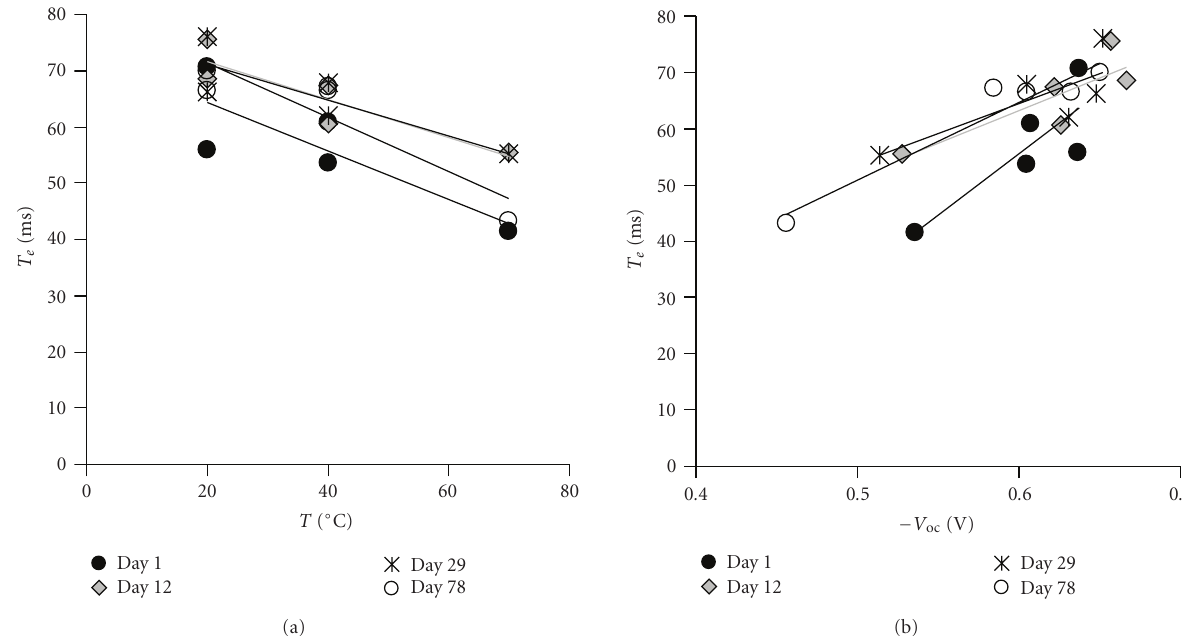
Figure 11: Electron lifetimes in the TiO 2 film, as a function of temperature (a) and open circuit voltage (b); first set of EIS measurements.